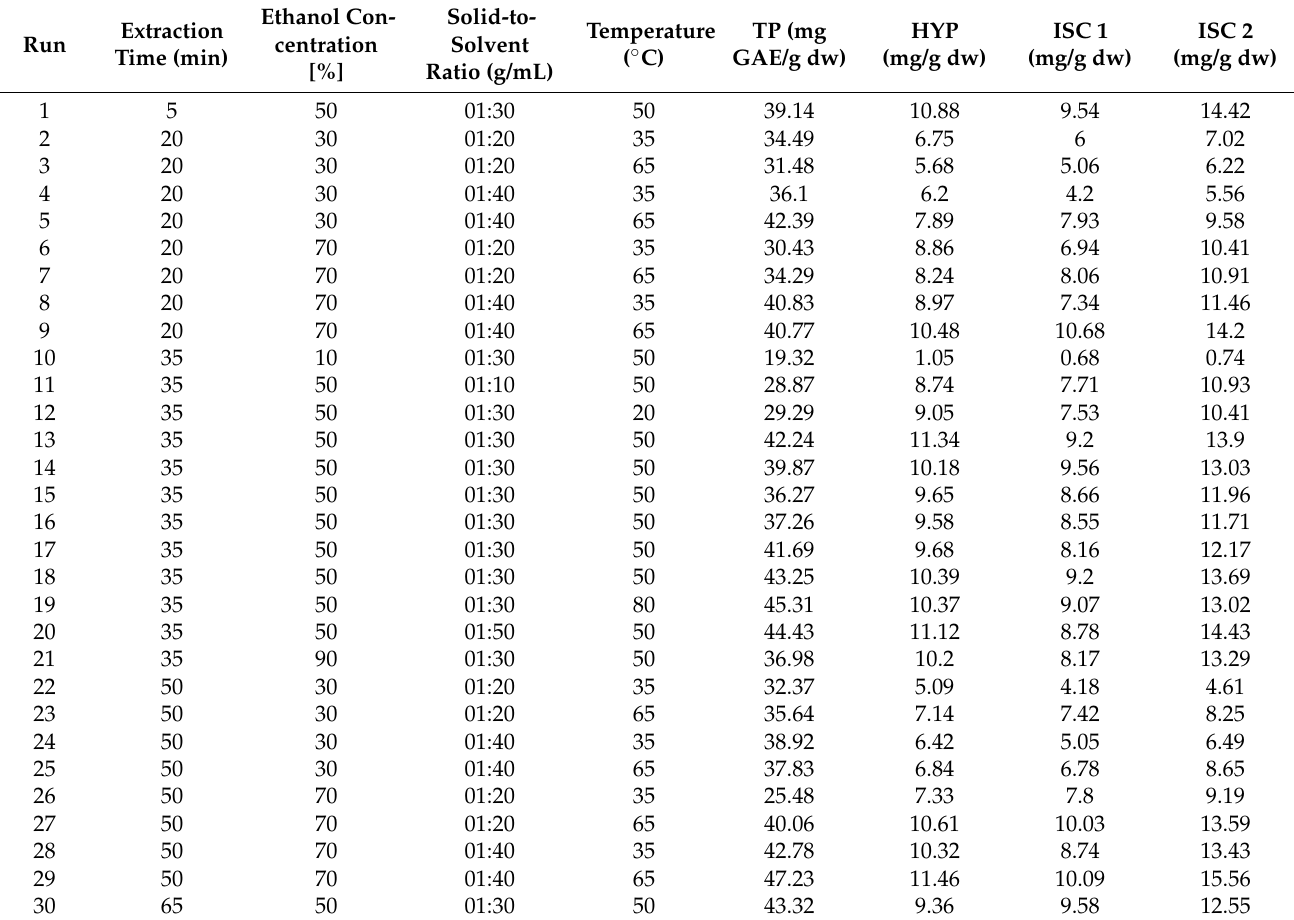
Table 2. Central composite design with UAE parameters and experimentally obtained values of TP, HYP, ISC 1, and ISC 2 a . Extraction Run Time